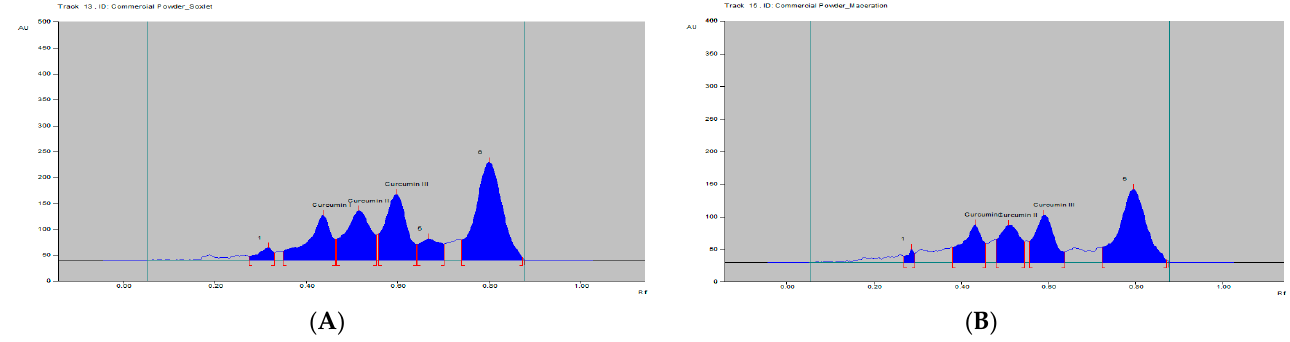
Figure 4. HPTLC densitogram of dry C. longa extract by ( A ) soxhlet and ( B ) maceration.